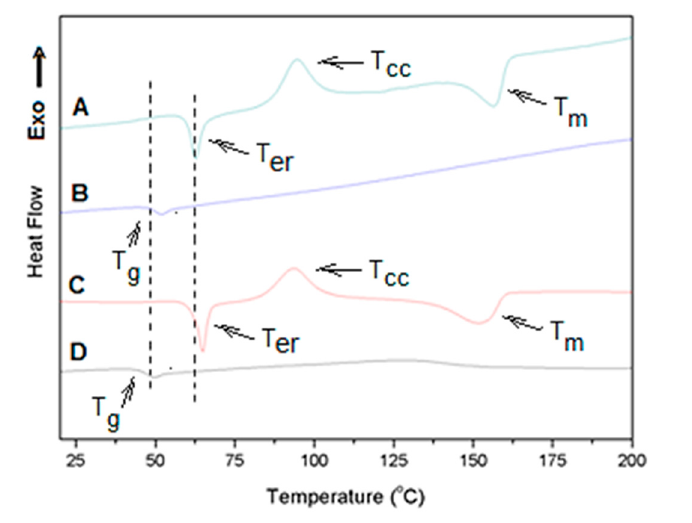
Figure 5. Differential scanning calorimetry (DSC) traces of non-irradiated and irradiated control PLGA nonwovens. ( A – B ) First heating run and second heating run, respectively, of non-irradiated membranes and ( C – D ) first and second heating run, respectively, of irradiated membranes.